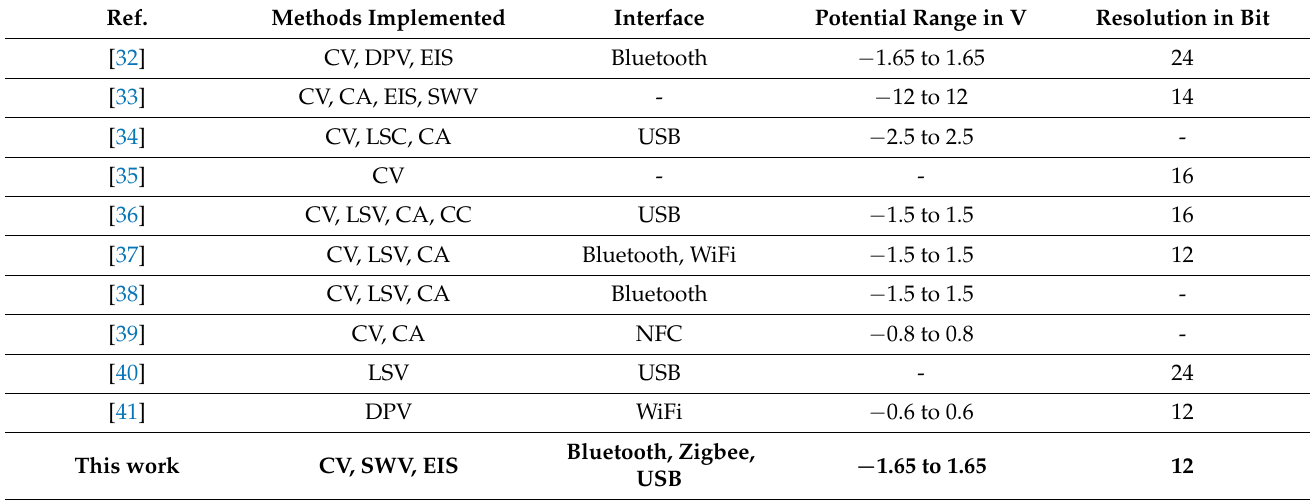
Table 1. Comparison of the specifications of different potentiostats from the literature.